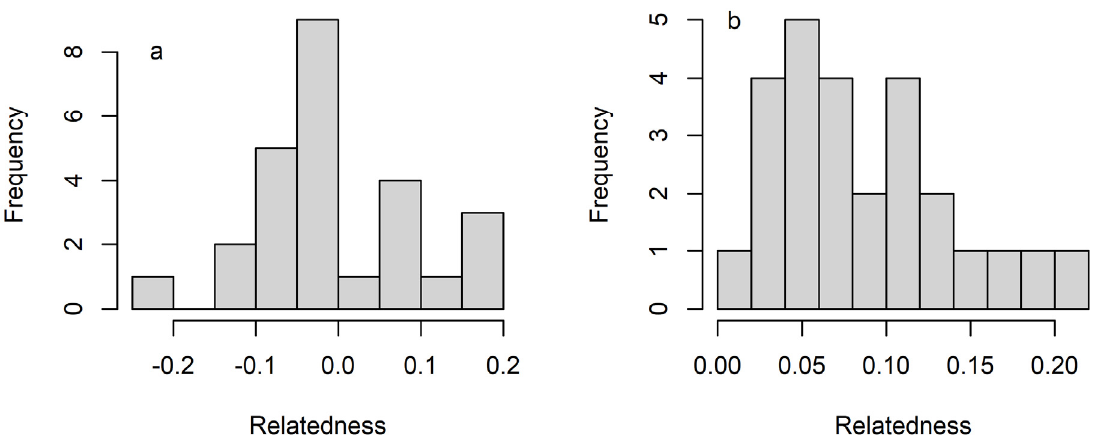
Figure 1. Relationships between the genetic relatedness (Queller and Goodnight coefficients) and genetic diversity (Shannon diversity index) of ( a ) Daurian pikas and ( b ) Mongolian gerbils in Inner Mongolia, China. The letter β is the estimate of regression slope.